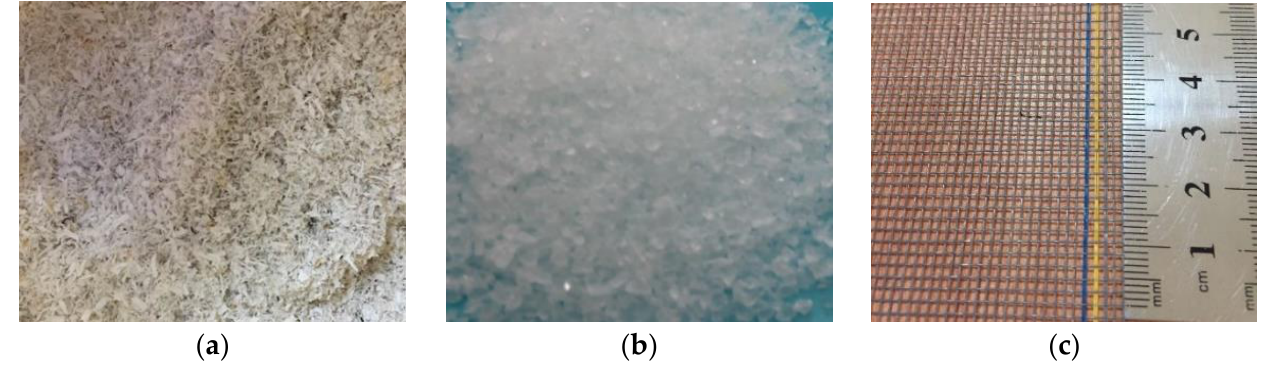
Figure 1. ( a ) PVC fine waste aggregates, ( b ) PVA as powder, and ( c ) Fiber wire Table 1. Composition of ordinary Portland cement (Type I) used in concrete mixes. Constituent Ordinary Portland Cement (Type I) % by Weight